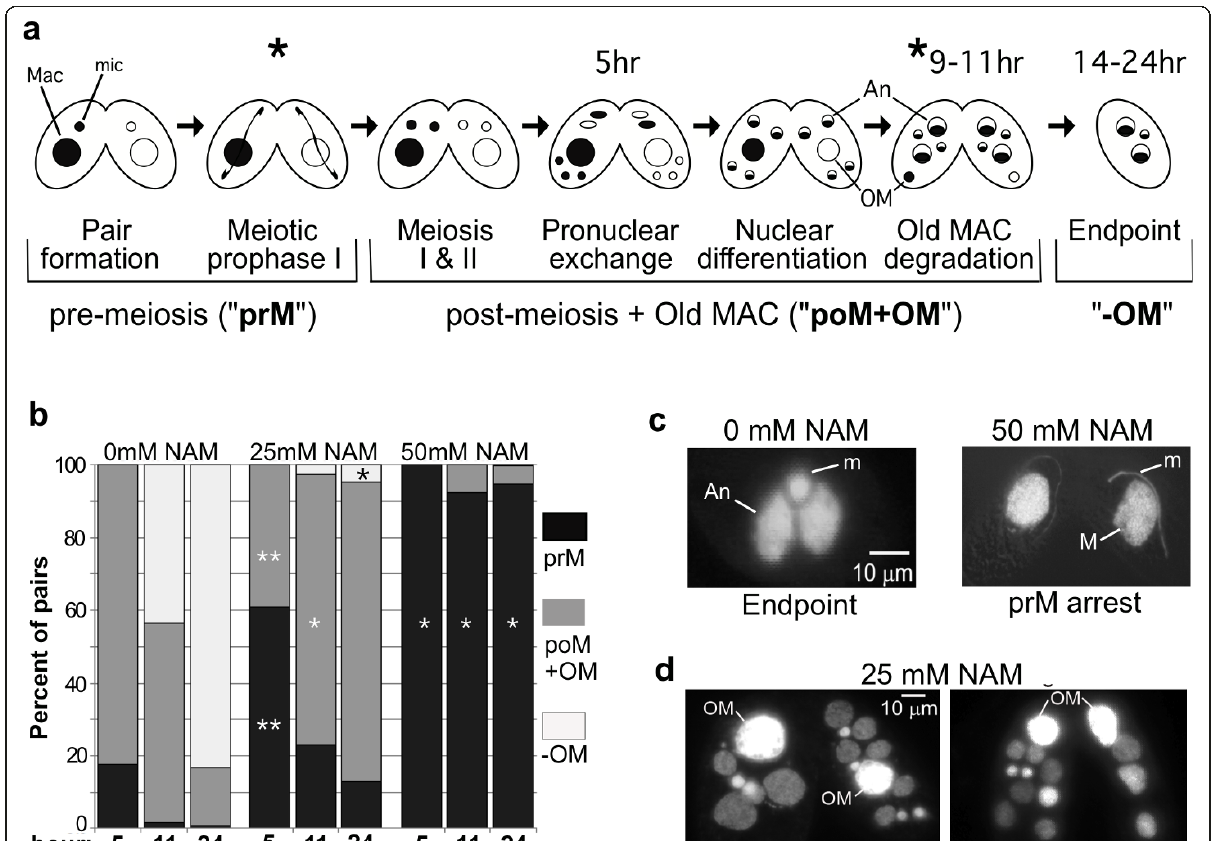
Figure 1 Nicotinamide treatment causes arrest in meiotic prophase and prevents macronuclear degradation . a Schematic of nuclear events in conjugation. Macronuclei are represented as large spheres, micronuclei as small spheres. Two mating types (white and shaded) were mixed to initiate conjugation. Asterisks represent the stages of arrest observed after nicotinamide treatment (coinciding with images in parts c and d). Hours represent times at which untreated conjugating cells (0 mM NAM) reach the given stage. Labels below the brackets indicate stages assessed in part b that correspond to different shades in the bar graph. “ pOM+OM ” are post-meiotic stages that still have a parental macronucleus (old macronucleus; OM); “ -OM ” is any stage after loss of the old macronucleus. An, anlagen (new macronuclei). b The average percentage of conjugating pairs at each of the three stages illustrated in part a by brackets: “ PrM ” , cells in pre-meiosis (black); “ pOM+OM ” , cells that contain an old macronucleus (dark gray); “ -OM ” , cells that have lost the old macronucleus (light gray). Nicotinamide was added just after mixing (time zero of conjugation) and analyzed at 5, 11, and 24 hrs postmixing. At least 200 cells over two separate trials were counted for each time point and NAM concentration (each bar). ** P < 0.01 in a t-test when compared to 0 mM NAM at the same time point and stage of meiosis; *P < 0.05. c Representative images of DAPI-stained wild-type (0 mM NAM) and 50 mM NAM treated cells analyzed at 24-hrs into conjugation. M, macronucleus; An, anlagen; m, micronucleus. d DAPI images of 25 mM NAM-treated cells analyzed 24 hrs into conjugation. “ OM ” , old (parental)